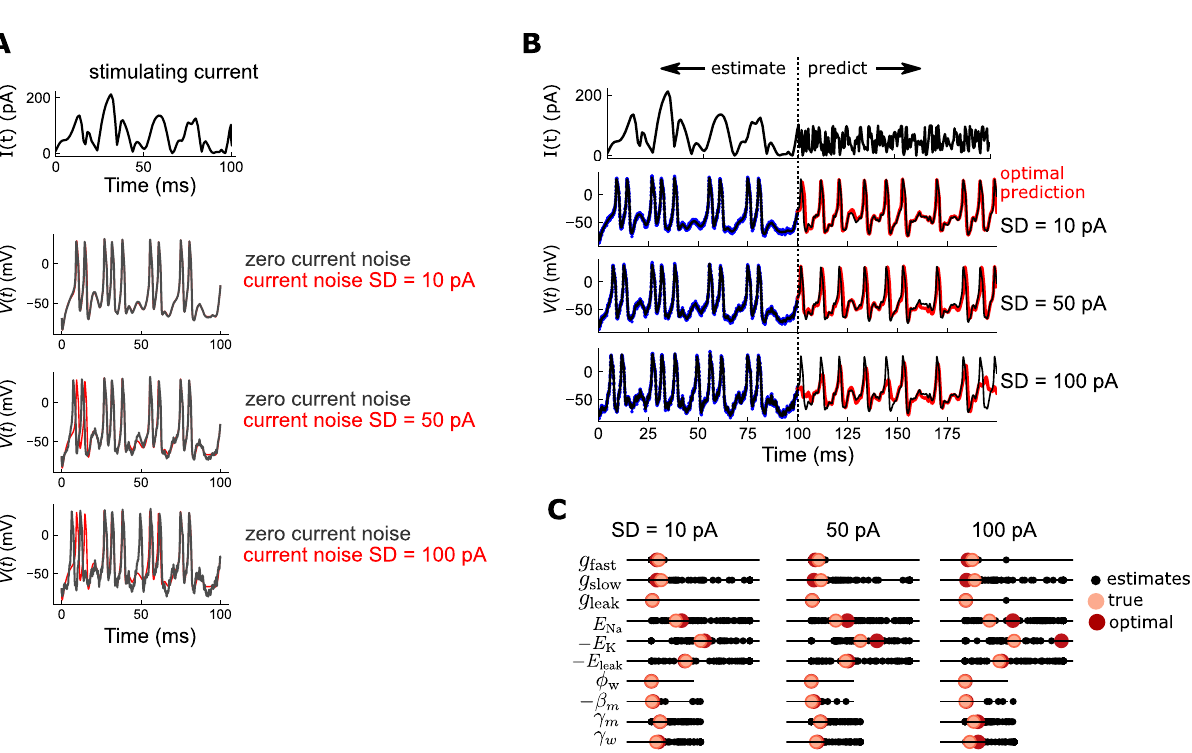
Fig 6. OC-DSPE estimation in the presence of noisy current inputs. A: (top trace) Stimulating current used for estimation of parameters. (bottom 3 plots) Resulting voltage traces for the stimulating current, for injected current noise levels of σ = 10, 50, 100 pA (light red traces), overlaid with the trace for zero injected current (light black traces). Here, injected current noise acts as a type of model/process noise, since it affects the evolution of the dynamics directly. This contrasts with the “measurement noise” used above, which is uncorrelated, additive noise added to the hidden state space output. B: (top trace) Injected current used for estimation (0 to 100 ms) and prediction (100 to 200 ms). (bottom 3 traces) True trajectory (black), observed data (blue), and optimal estimate (red), for 3 noise levels, respectively, 10, 50, 100 pA. Observed data is generated by integrating the model dynamics with process noise at the level indicated (10, 50, 100 pA), and then adding measurement noise σ = 2 mV to the output. C: Predicted parameters for 100 estimations, for 3 model noise levels. Black dots: all estimates; red: parameter corresponding to the optimal estimate; pink: the true parameter estimate.